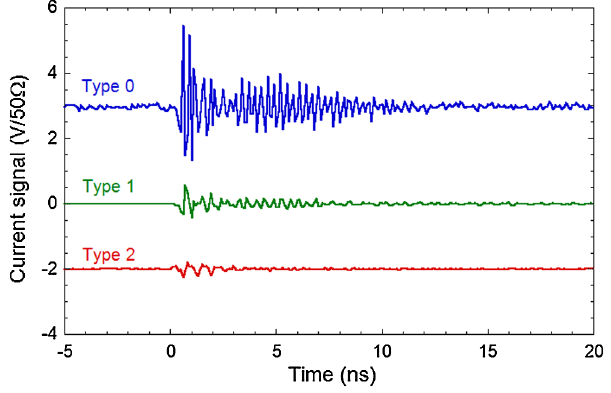
FIG. 5. Pulse shape without effect of the wakefield. The pulse heights are normalized by the